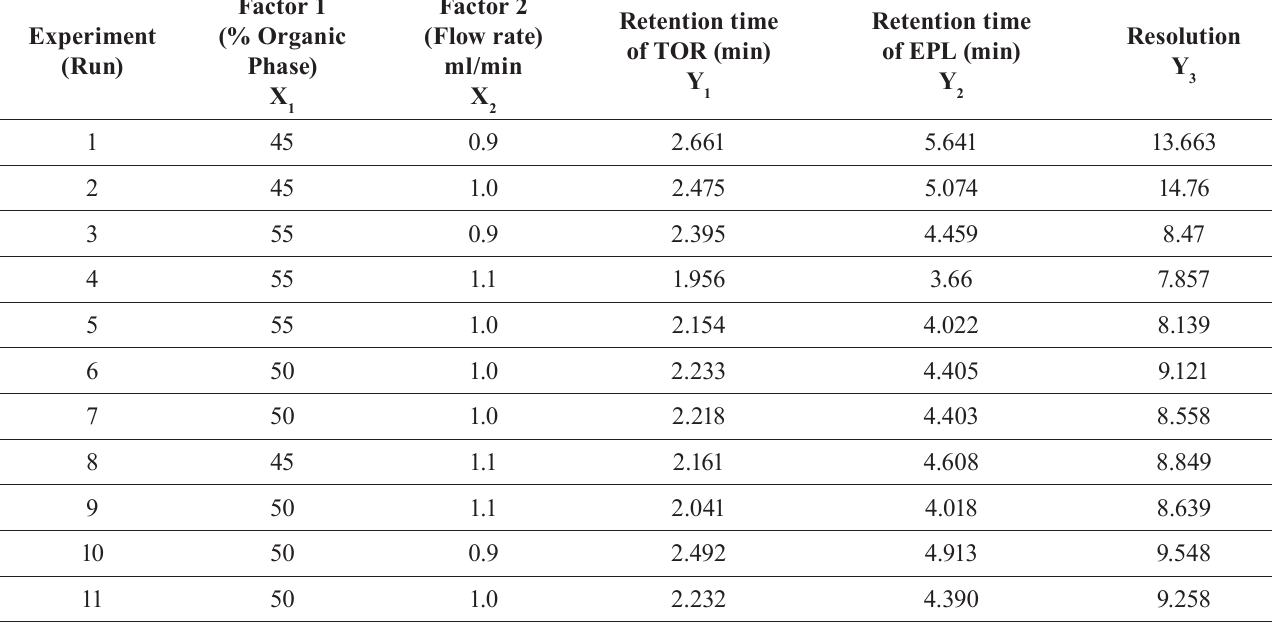
TABLE II - Coded values for factor level and observed responses in CCD for 11 analytical trials